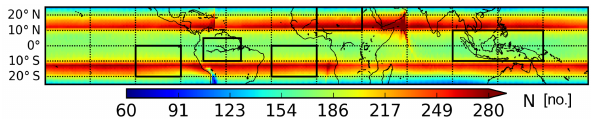
Figure 5. Mean number of overpasses per hour for SAPHIR chan- nel 6. Color bar shows number of observations per grid point. Num- ber of overpasses are generally higher for other channels than for channel